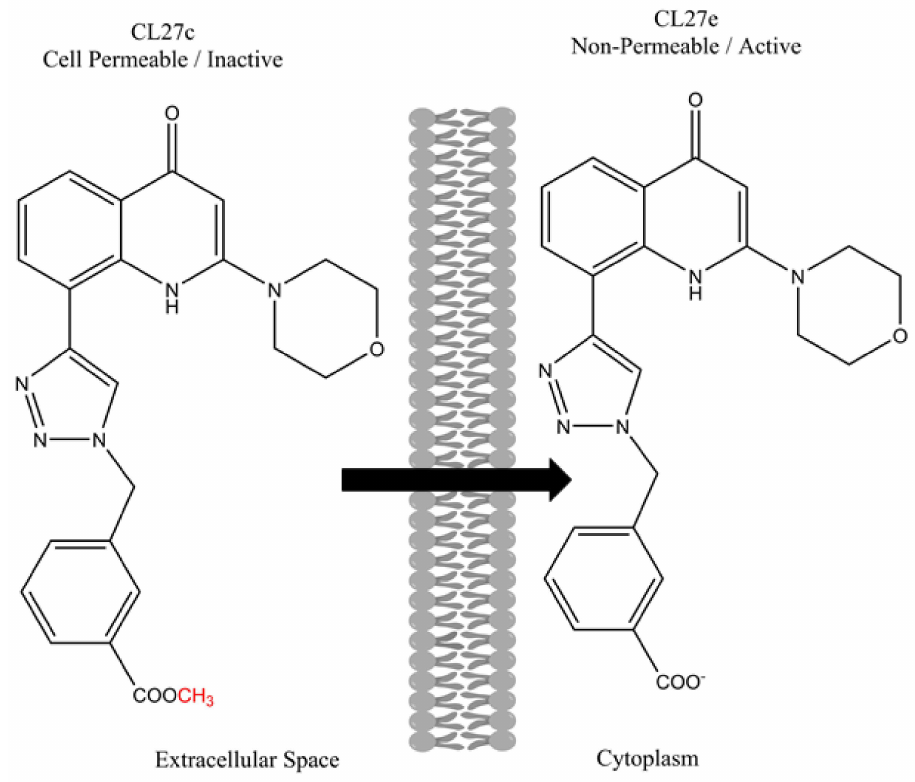
Figure 4. Chemical structures of the active compound CL27e and the corresponding methyl ester prodrug CL27c. Adapted from